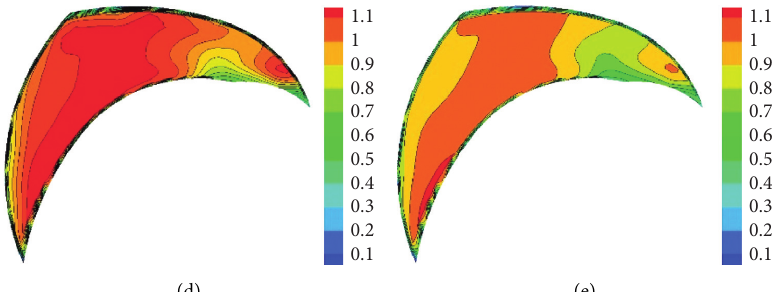
Figure 12: Distribution of slip factor in flow channel: (a) 600r/min 1.0 Q 1.0 Q BEP , and (e) 1400r/min 1.0 Q BEP .